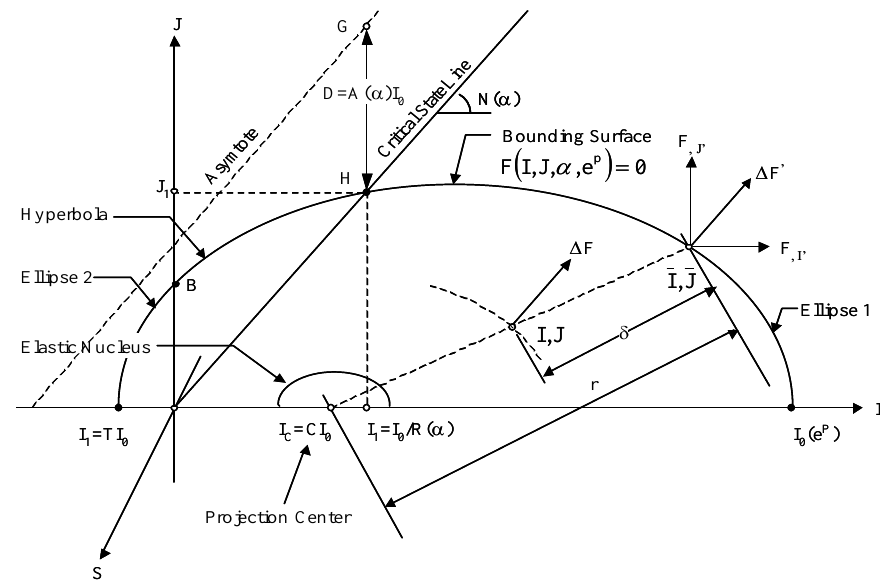
Figure 5. Schematic of a bounding-surface constitutive model in stress-invariant space. Table 1. Calibrated bounding surface model parameters. Parameter Value Slope of virgin consolidation line in e-ln(p) plot, λ Slope of swelling line in e-log(p) plot, κ Slope of critical state line in compression, M c Ratio of extension to compression for slope of critical state line, M e /M c (cid:0) × Elastic shear modulus, G 10 6 kPa